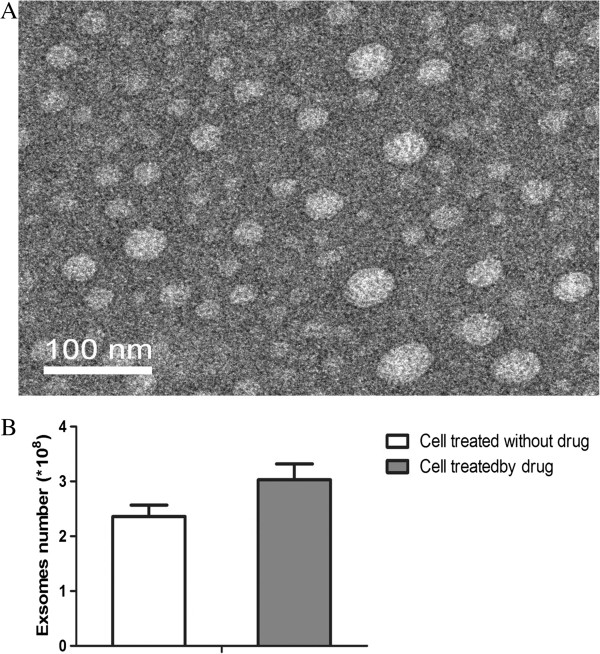
The electron microscope observation result of exosomes secreted from hepatoma G2 cells. (A) The microcapsule of exosomes have a diameter of 30 to 80 nm. (B) Column comparison of exosome expression with or without MS-275.